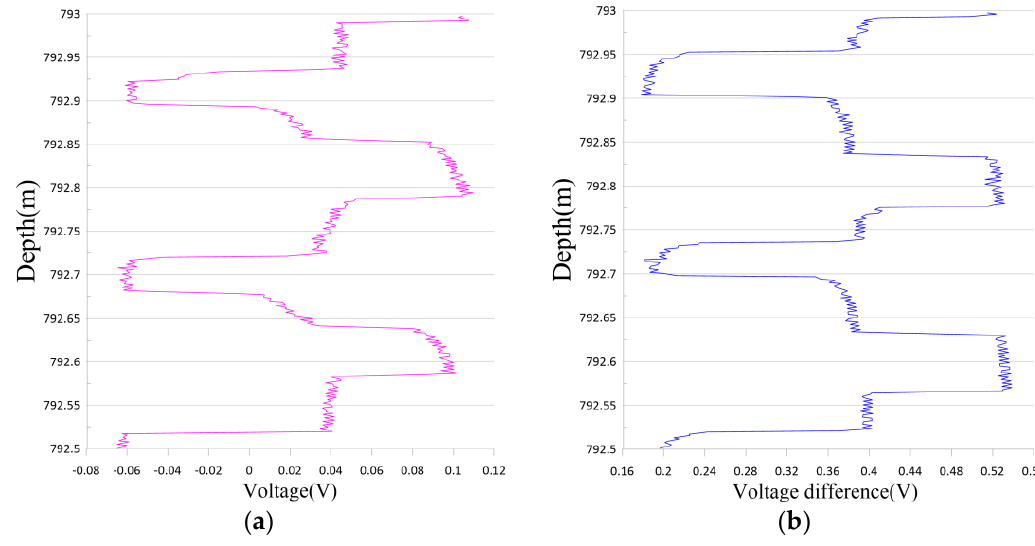
Minerals 2022 , 12 , 1247 Figure 22. Raw data recorded by the receiver ( a )Voltage; ( b )Voltage difference.